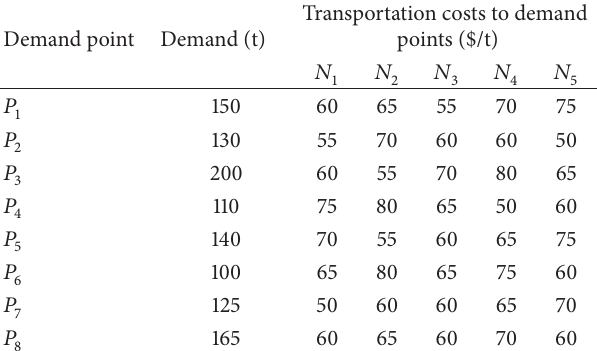
Table 3: Demands and transportation costs.